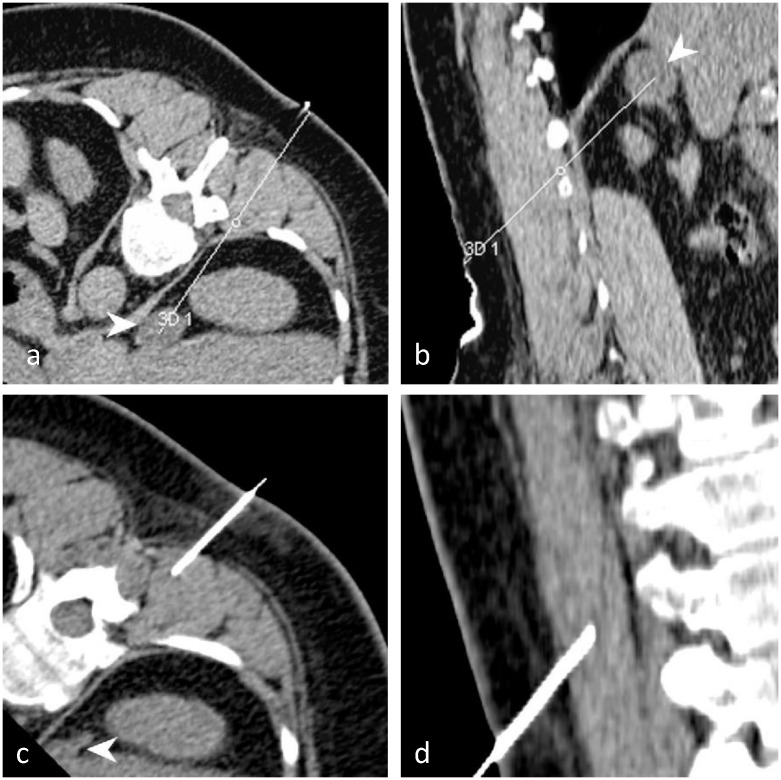
Illustration case (CT).This 54 year old female patient had a growing right adrenal gland mass (white arrow) and an indication for a percutaneous CT-guided biopsy. She gave written informed consent. The operator (resident) in agreement with the supervising senior operator predicted a difficult intervention, due to the necessity of a double angulated trajectory. The patient was randomized to the CT group. The planned trajectory was saved on the CT console. The control CT acquired after the initial needle placement (step Δ1) showed a large difference between the planned (a, b) and the achieved trajectories (multiplanar reconstructions) (c, d). Twelve more attempts and iterative CT control acquisitions were required to reach the target (step Δ2). After biopsy, the last control acquisition showed a small periadrenal hematoma without the need for additional treatment. Pathologic findings on the biopsy sample showed adrenal tissues with metastasis from a malignant lung tumor.